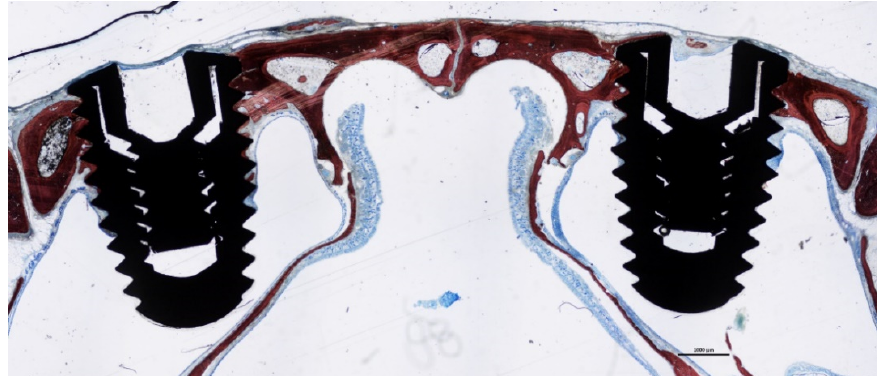
Figure 4. Photomicrographs of a histological ground section showing the position of the implants within the sinus. The primary stability was secured by the cortical layer of the nasal bone. After 8 weeks of healing, at the histological analysis, the sinus mucosa appeared to be collapsed around the implant body (Figure 5A).